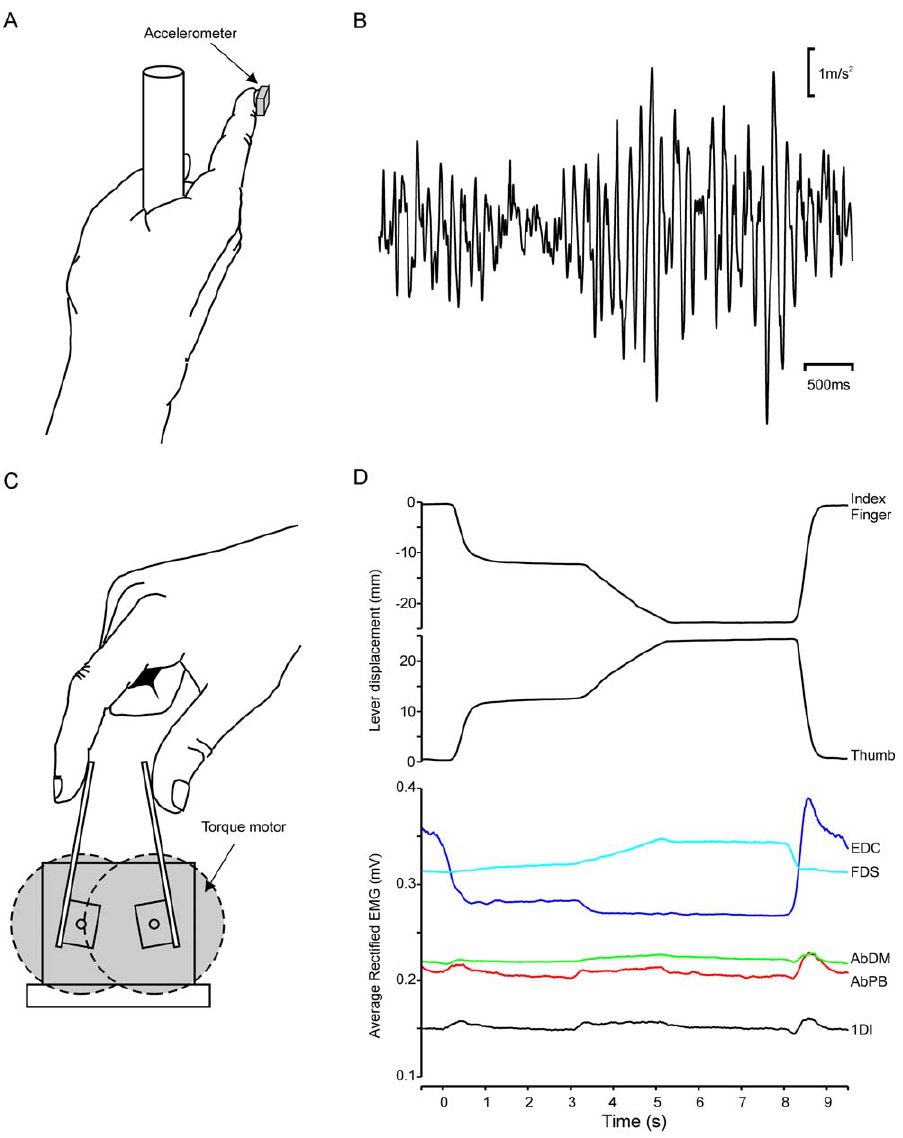
Figure 1. Experimental tasks. A. Postural tremor task. B. Example of postural physiological tremor in a single subject, recorded via an accelerometer. C. Auxotonic precision grip task. D. Lever displacement and average rectified EMG recorded from extensor digitorum communis (EDC), flexor digitorum supeficialis (FDS), abductor digiti minimi (AbDM), abductor pollicis brevis (AbPB) and first dorsal interosseous (1DI) muscles in a single subject during a single trial of the auxotonic task.